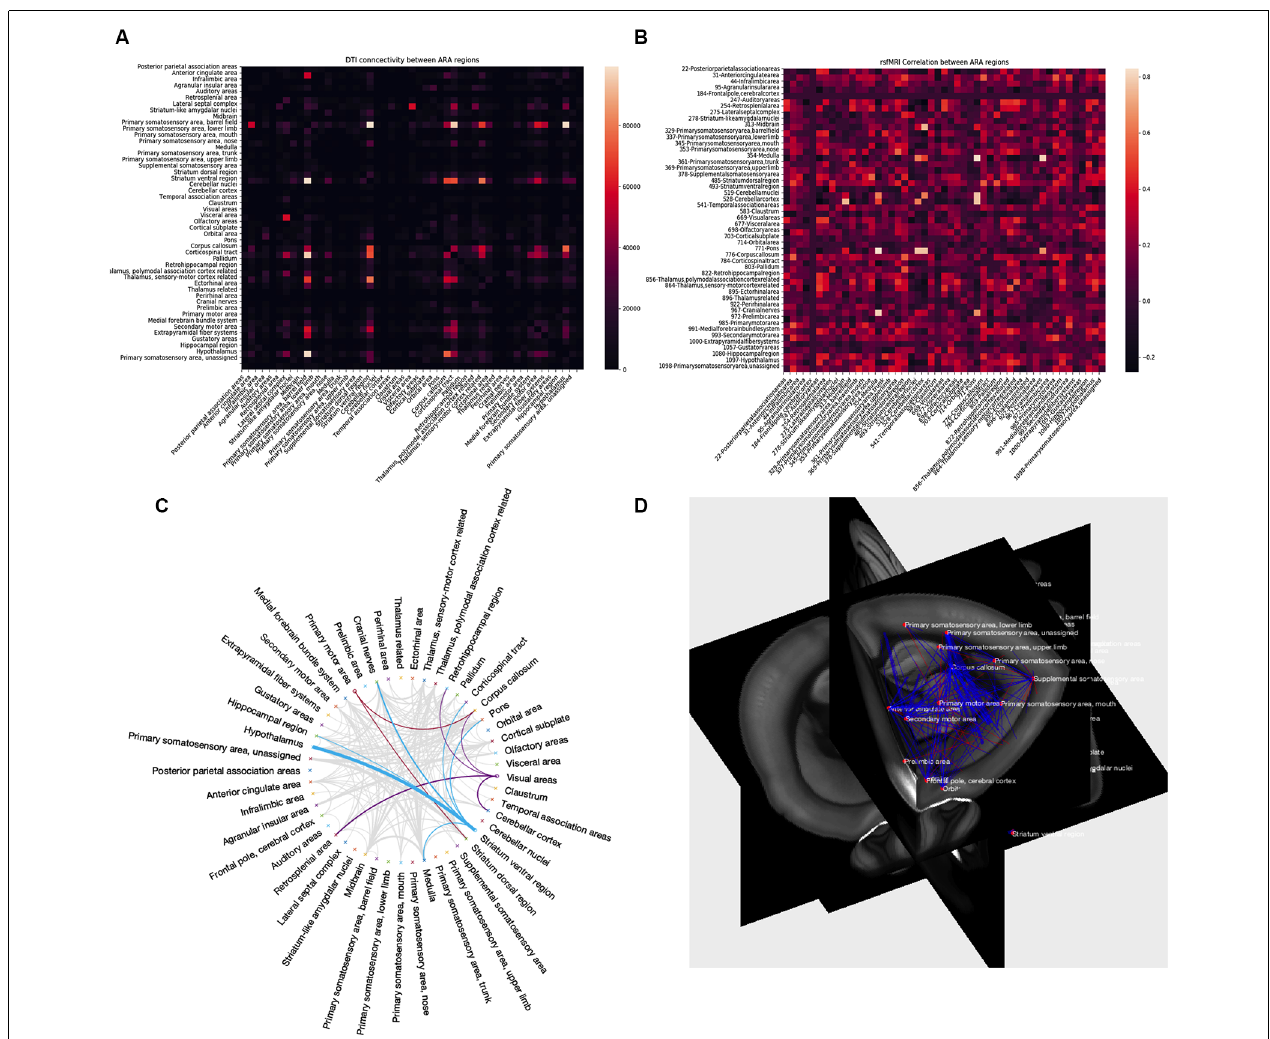
FIGURE 8 | AIDAmri output. Structural and functional information of DTI (A) and fMRI (B) can be represented as adjacency matrices by using the plot function. The entries in the matrices represent the number of tracks passing or ending in the ARA regions of the DTI and activity pattern of rs-fMRI among all ARA regions to evaluate the results using graph theoretical approaches. Other ways to visualize connectivity patterns (plot function not included in AIDAmri): the circular representation of a row or column vector (C) where thicker lines relate to higher matrix values (C) and 3D visualization of connectivity in the anatomical context, here the registered atlas (D)